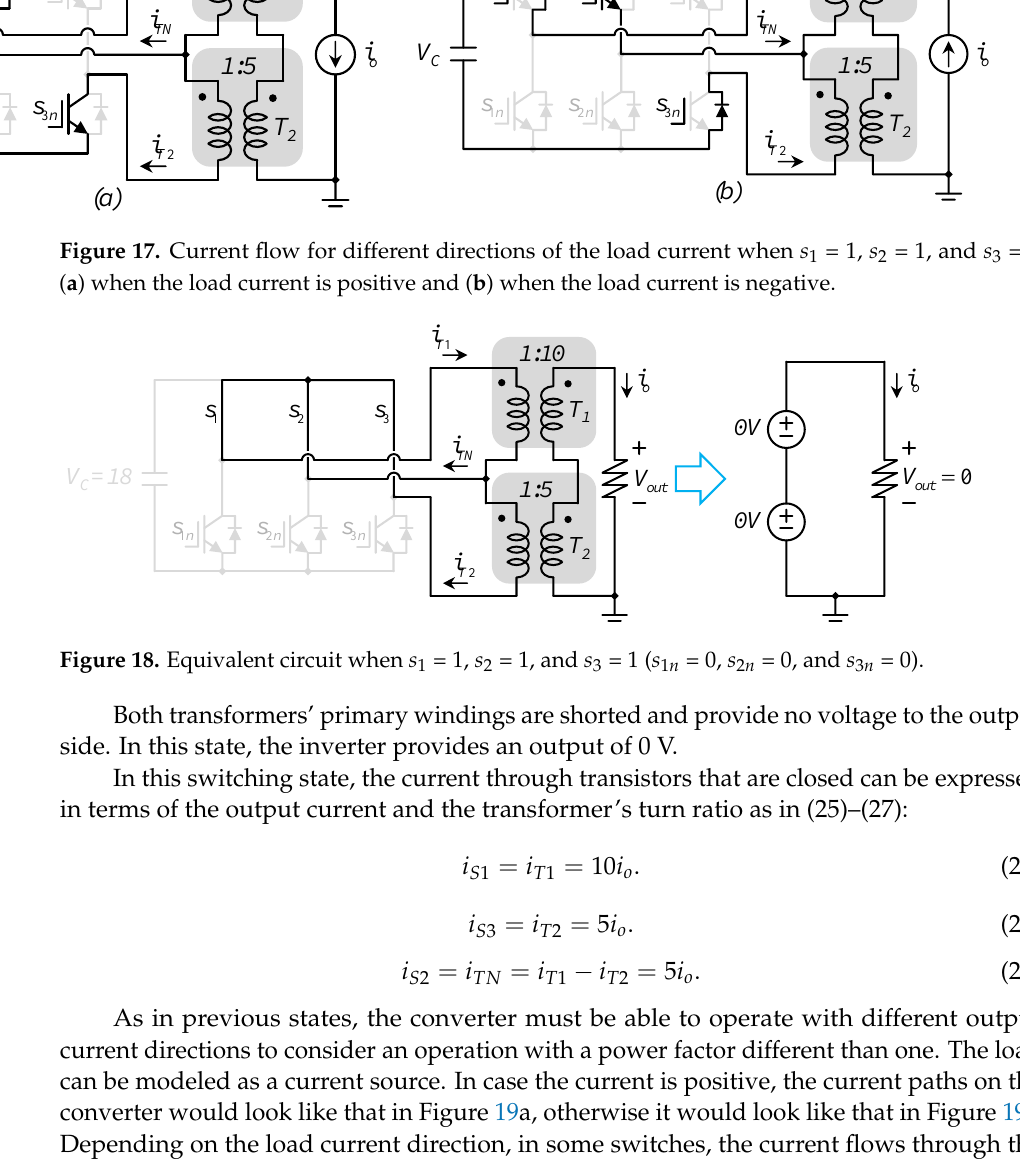
through the transistor, and in other cases it flows through the diode.